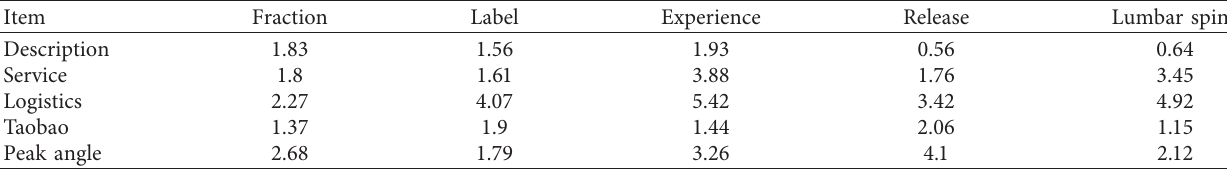
Figure 7: Statistical analysis of user reviews. Table 5: Delivery speed and delivery staff’s service attitude.